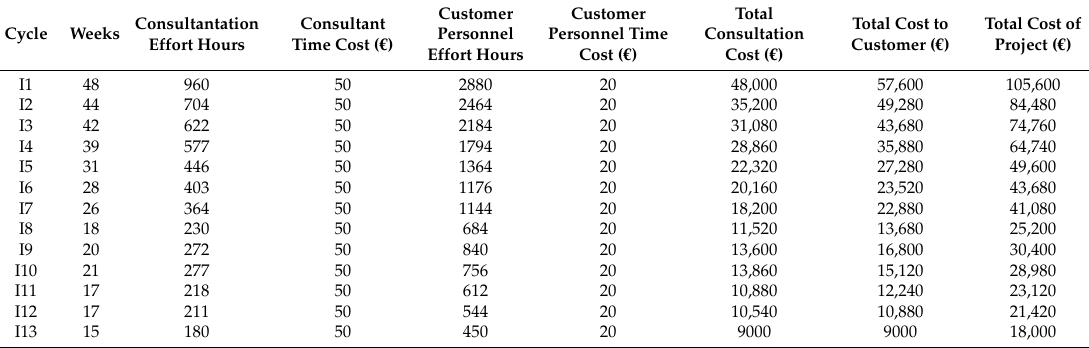
Table 1. Comparison of time taken and costs as regards consultations and customers for each iteration.